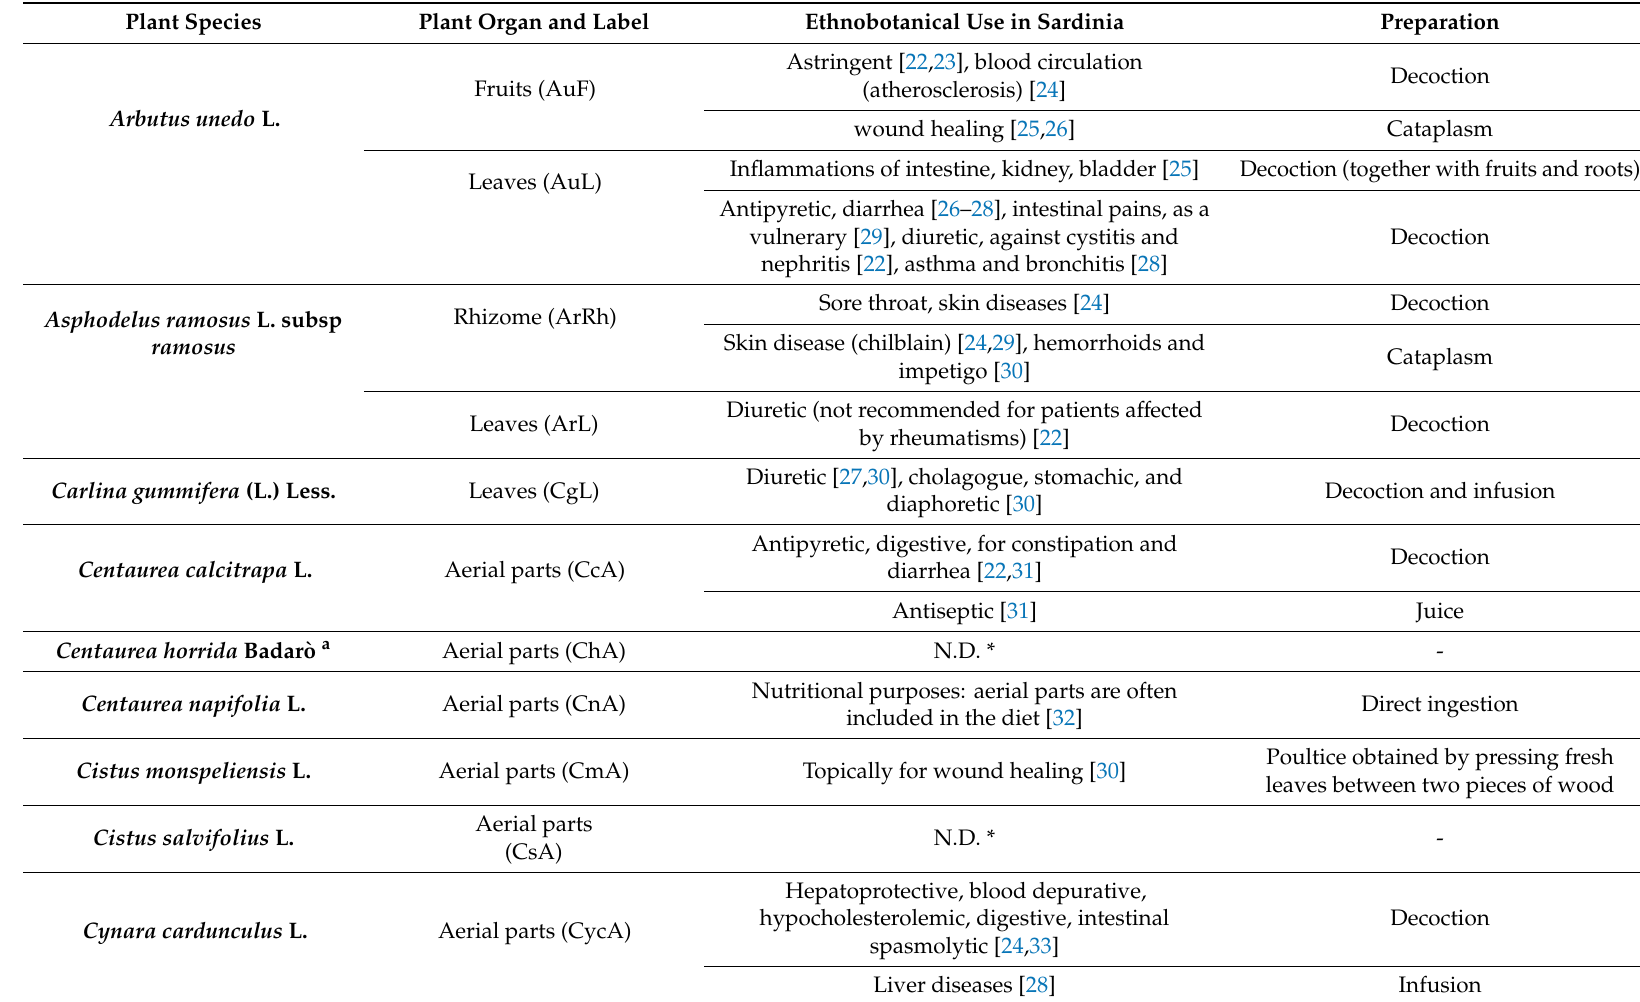
Table 1. Ethnobotanical use of investigated plants in Sardinian traditional medicine. Up-to-date information on plants analyzed in this work. Traditional uses related to specific organs as well as preparation are